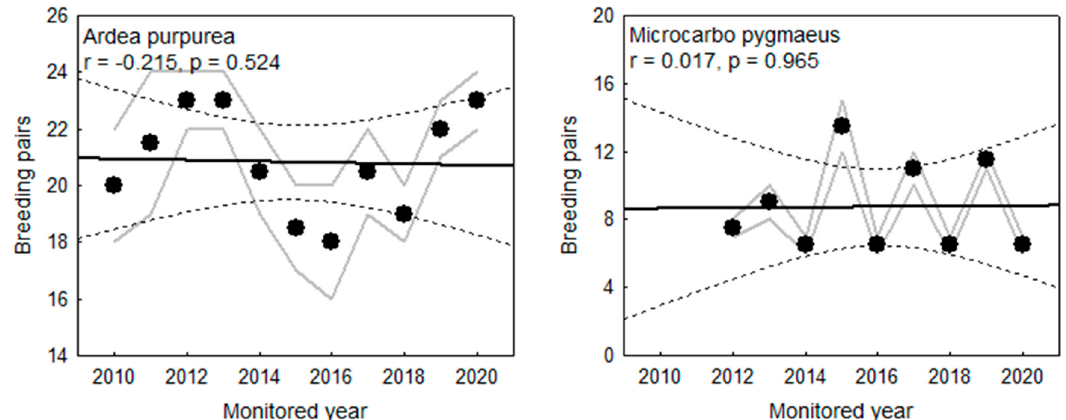
Figure 11. Population trend over last 10 years for Ardea alba , Egretta garzetta , Nycticorax nycticorax , Ardeola ralloides , Ardea purpurea , and Microcarbo pygmaeus . Linear regression (continuous black line) and associated 95% confidence interval (dotted black line). Gray lines represent minimal and maximal estimated breeding pairs in the field.